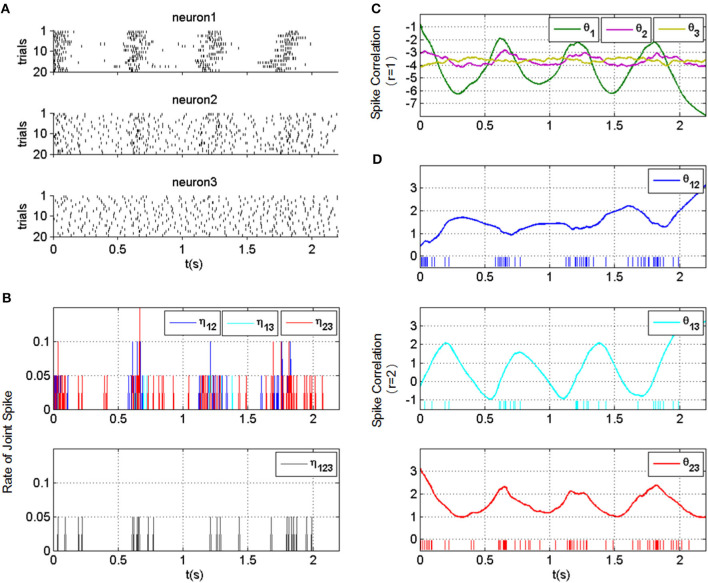
Estimation of spike correlations for acupuncture data evoked by twirling reducing. (A) Ensemble spike activities. The number of neurons is N = 3 and the number of trials is n = 20. (B) Rates of joint spike: η12, η13, η23, and η123. (C) First-order spike correlations: θ1, θ2, and θ3 (green, pink, and yellow solid lines). (D) Second-order spike correlations: θ12, θ13, and θ23 (blue, cyan, and red solid lines). Raster with different colors at the bottom show the timing of corresponding order synchronous spikes.